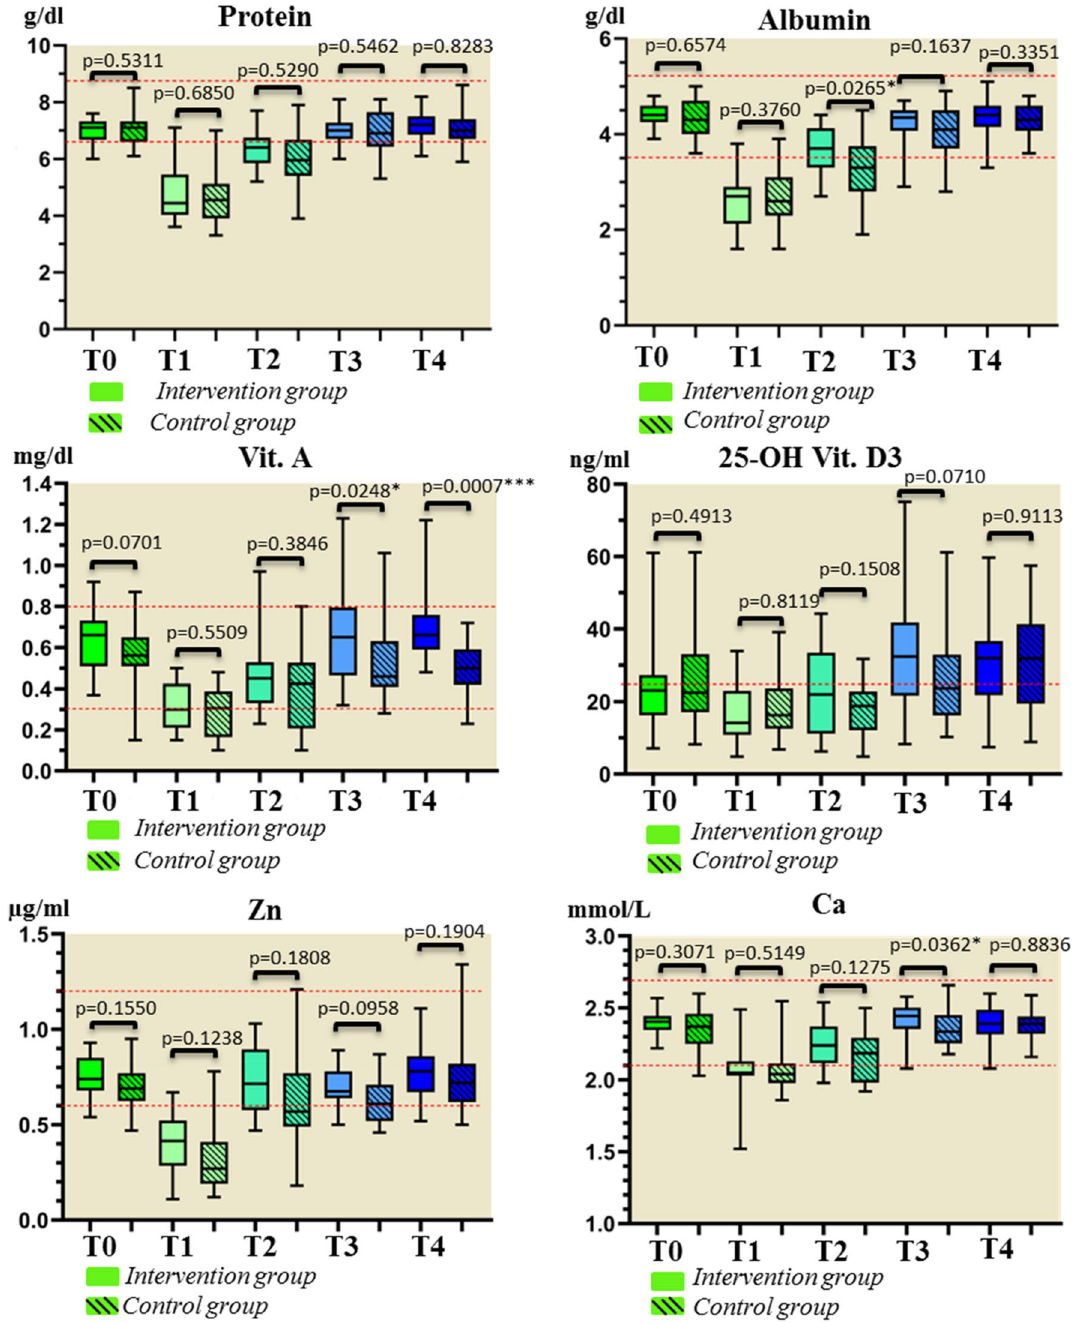
Figure 3. Labor parameters protein, albumin, vitamin A, vitamin D, zinc and calcium at measurement times T0 = before surgery, T1 = first day after surgery, T2 = before discharge, T3 = 3 months postoperative, T4 = 6 months